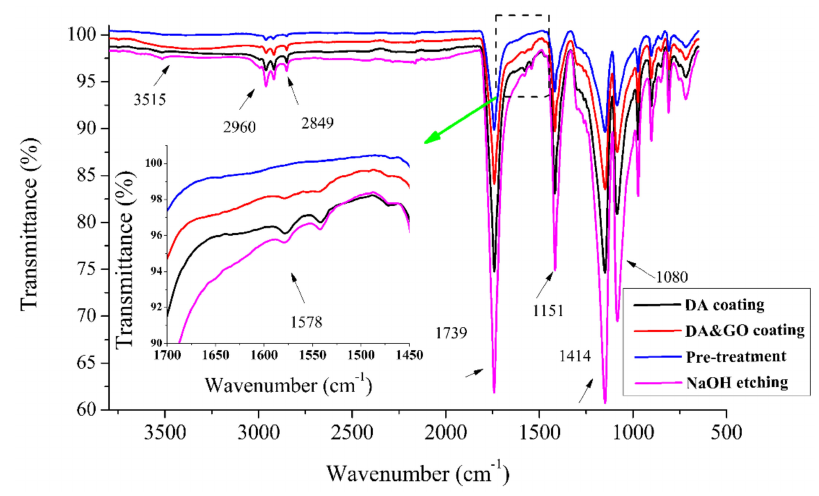
Figure 4. FT-IR of the polyglycolic acid (PGA) multifilament surgical sutures with and without di ff erent treatments (i.e., NaOH treatment and DA / GO coatings). The plot inside is a magnification of the infrared spectrum.